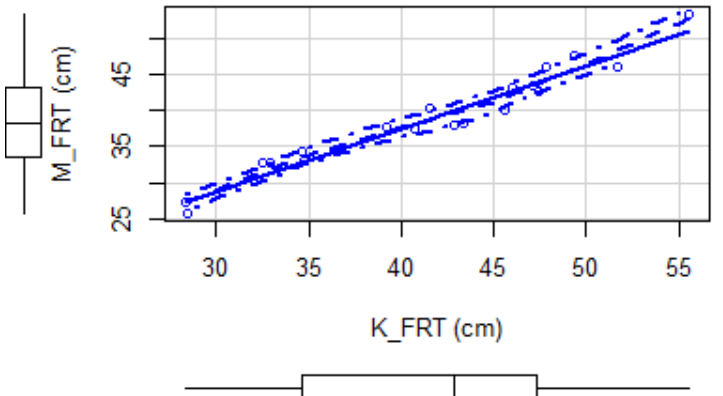
Figure 9. Scatter plot of the data obtained by the experimental system and manually in Experiment 1.